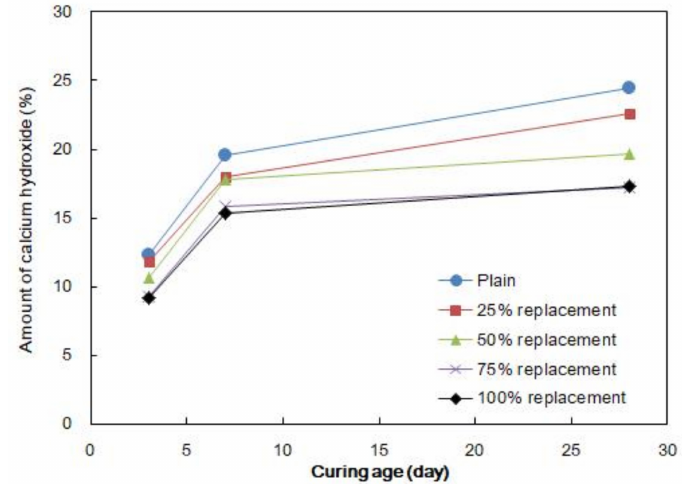
Figure 6. Amount of calcium hydroxide in cement mortar with borosilicate